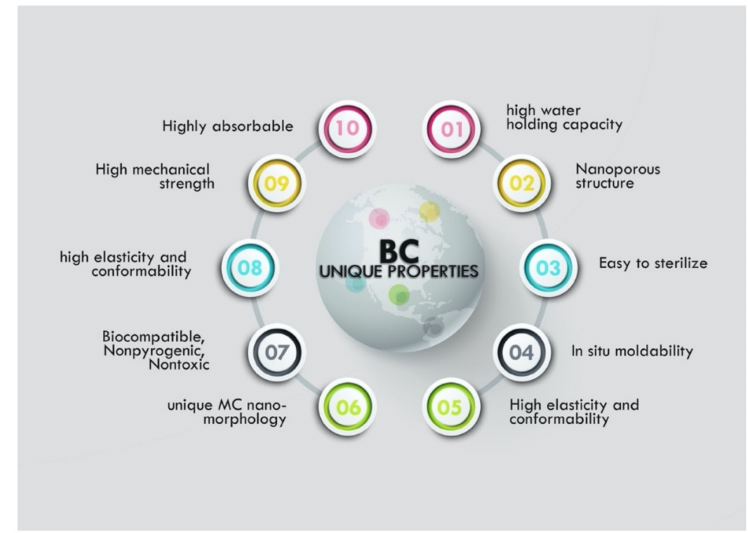
Figure 3. The unique properties of bacterial